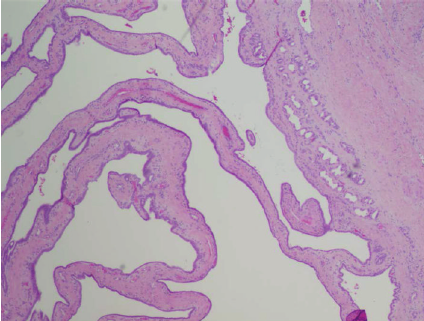
Figure 2: Low magnification revealing cystic tubules in a nest of fibrous stroma. Tubules are lined by cuboidal bile duct epithelium against the background of fibrous